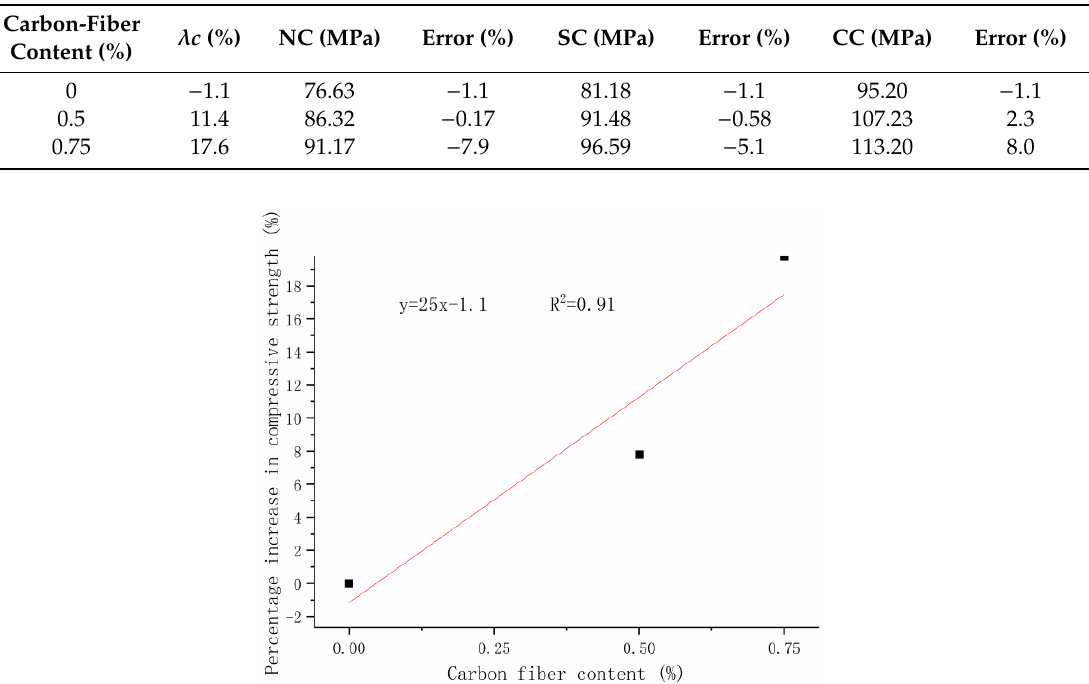
Table 10. RPC compressive strength from References